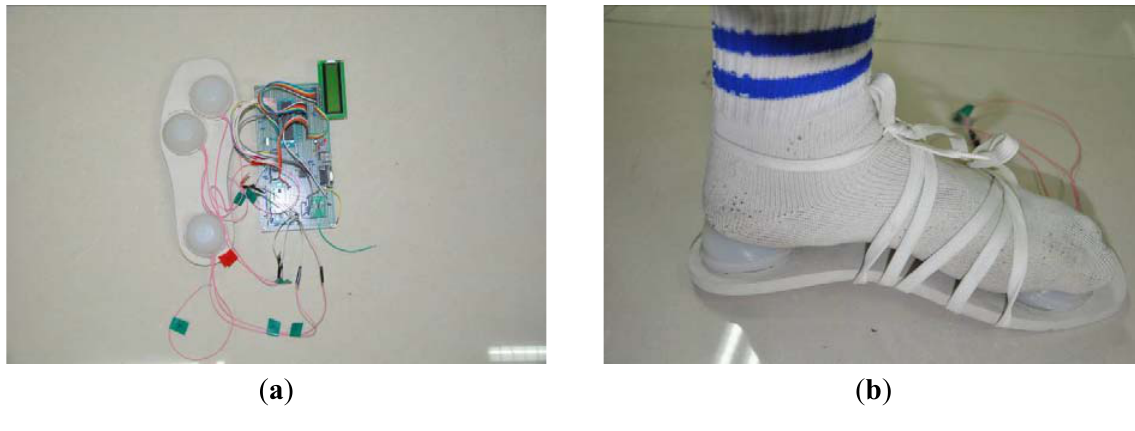
Figure 11. Pictures of the plantar force measurement test. ( a ) The designed plantar force measurement system; ( b ) The scene of the plantar force measurement.